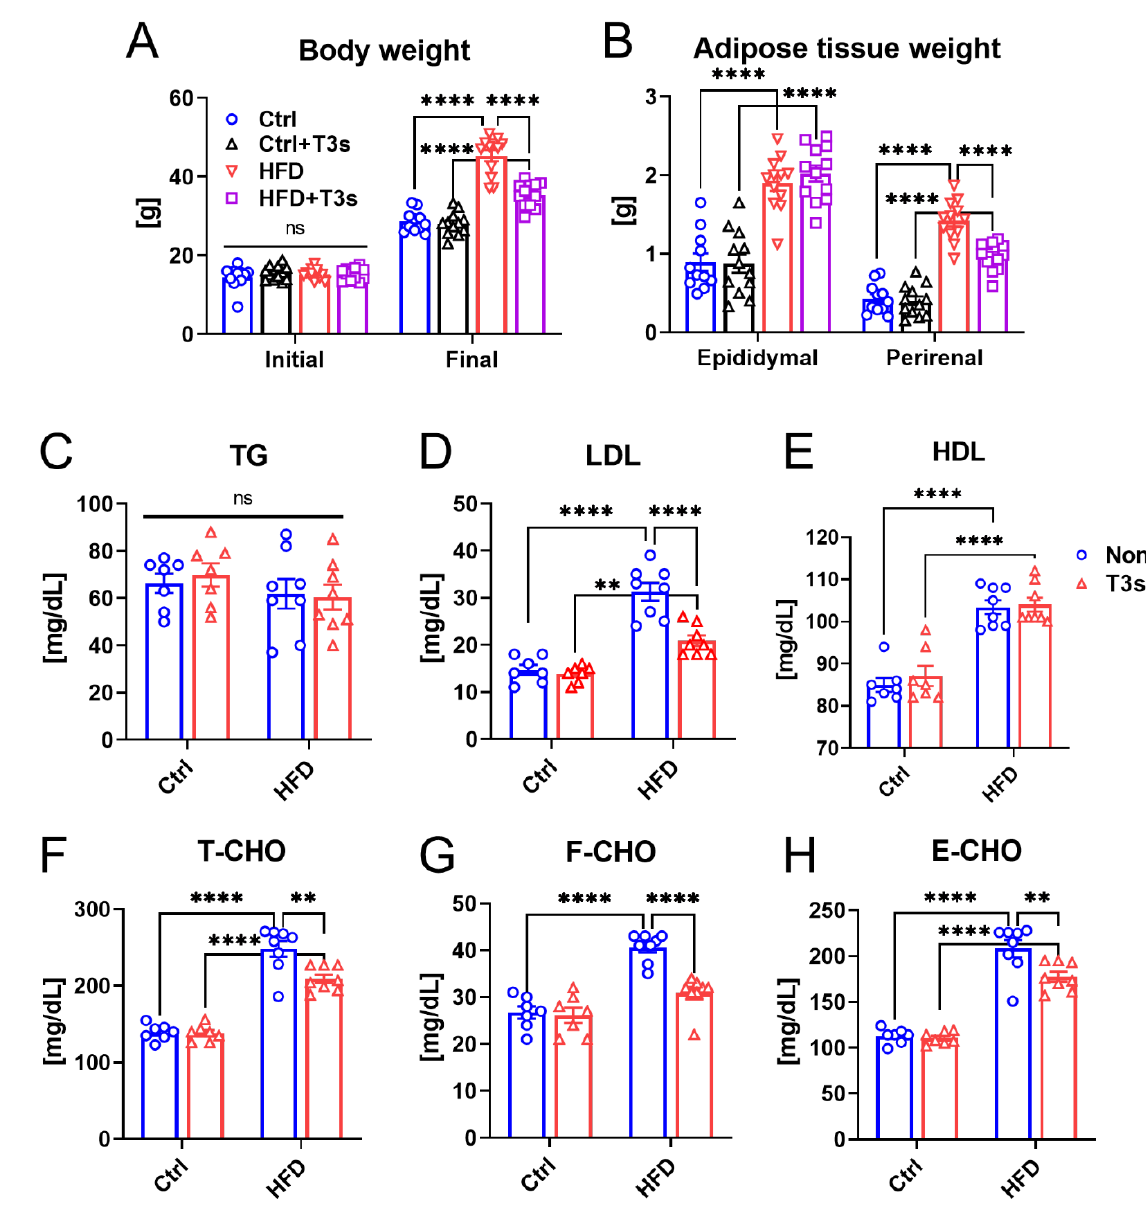
Figure 1. T3s inhibited body weight gain and improved serum cholesterol levels. ( A ) Body weights of each group on the first and final days of treatment. (Ctrl, n = 11; Ctrl + T3s, HFD and HFD + T3s, n = 12). ( B ) Weights of epididymal and perirenal fat. (Ctrl, n = 11; Ctrl + T3s, HFD and HFD + T3s, n = 12). ( C – H ) Serum cholesterol levels. (Ctrl and Ctrl + T3s, n = 7; HFD and HFD + T3s, n = 8). ** p < 0.01, **** p < 0.0001 two-way analysis of variance (ANOVA) with the Tukey Kramer method.